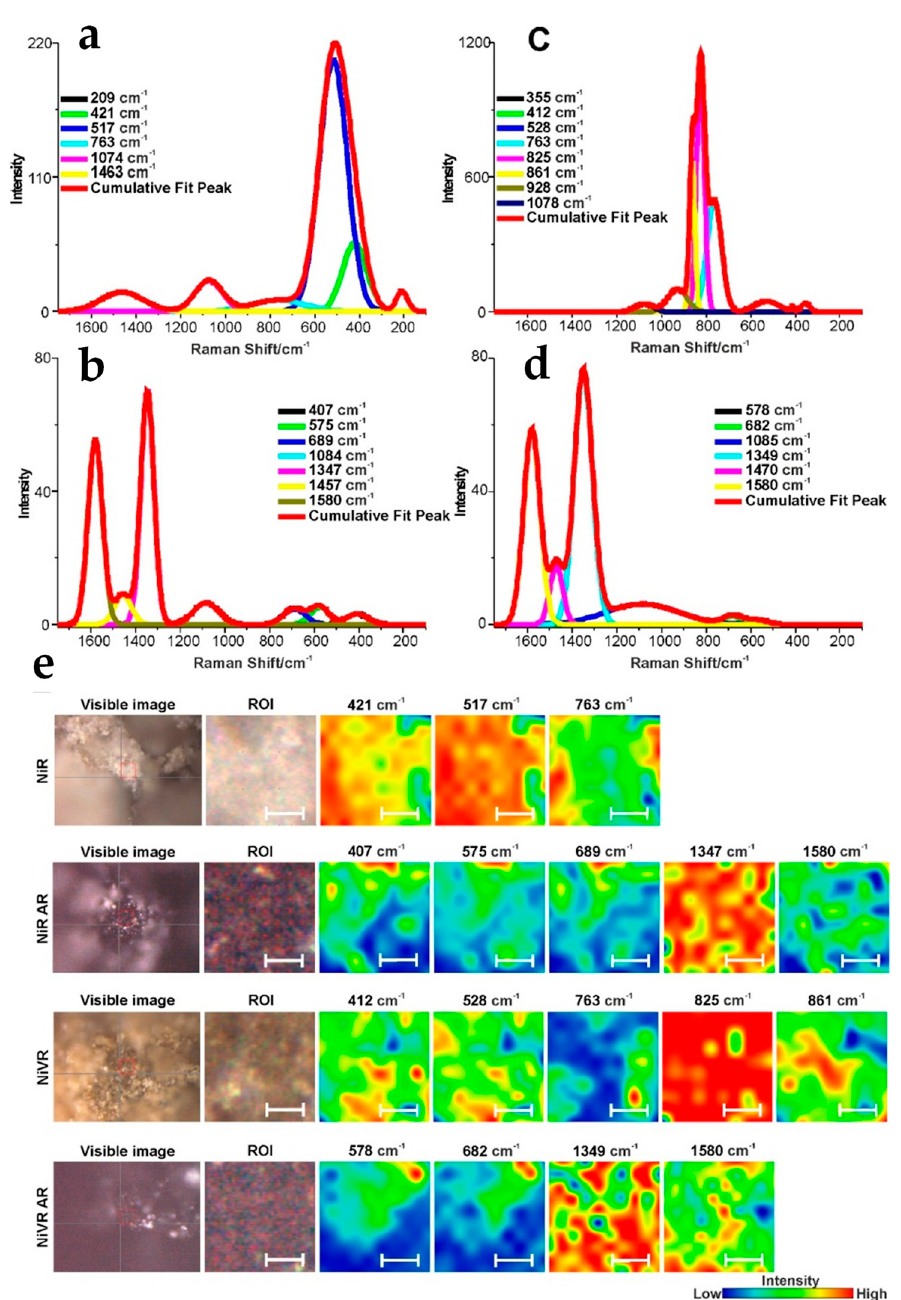
Figure 8. Raman deconvoluted spectra and chemical maps of NiR and NiVR samples before and after reaction (AR). ( a ) NiR before reaction spectrum, ( b ) NiR AR spectrum, ( c ) NiVR before reaction spectrum, ( d ) NiVR AR spectrum, ( e ) Raman maps with the distribution of selected bands for NiR before reaction, NiR AR, NiVR before reaction, and NiVR AR. Red spectra correspond to the cumulative spectrum consisting of the deconvoluted bands, other colors of the spectra correspond to the single deconvoluted bands. The white scale bar corresponds to 4.5 µm.